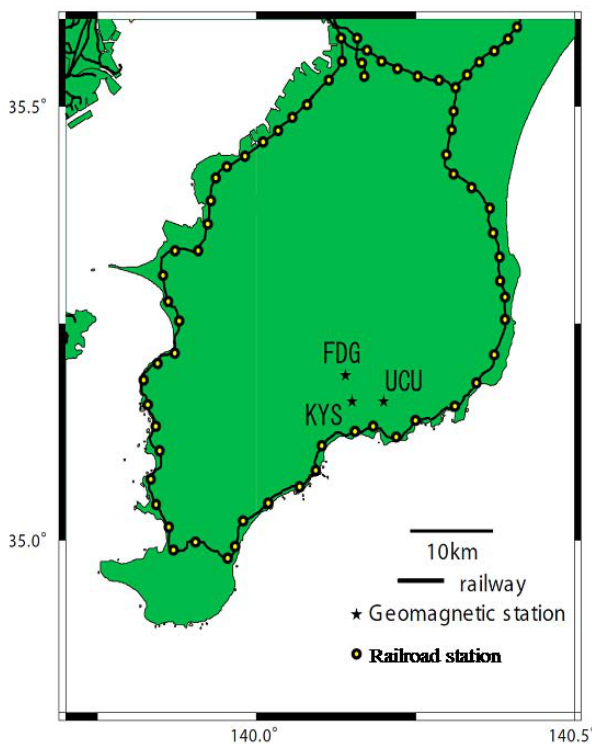
Fig. 12. The map of ULF stations and DC-driven railway routes in Boso Peninsula.